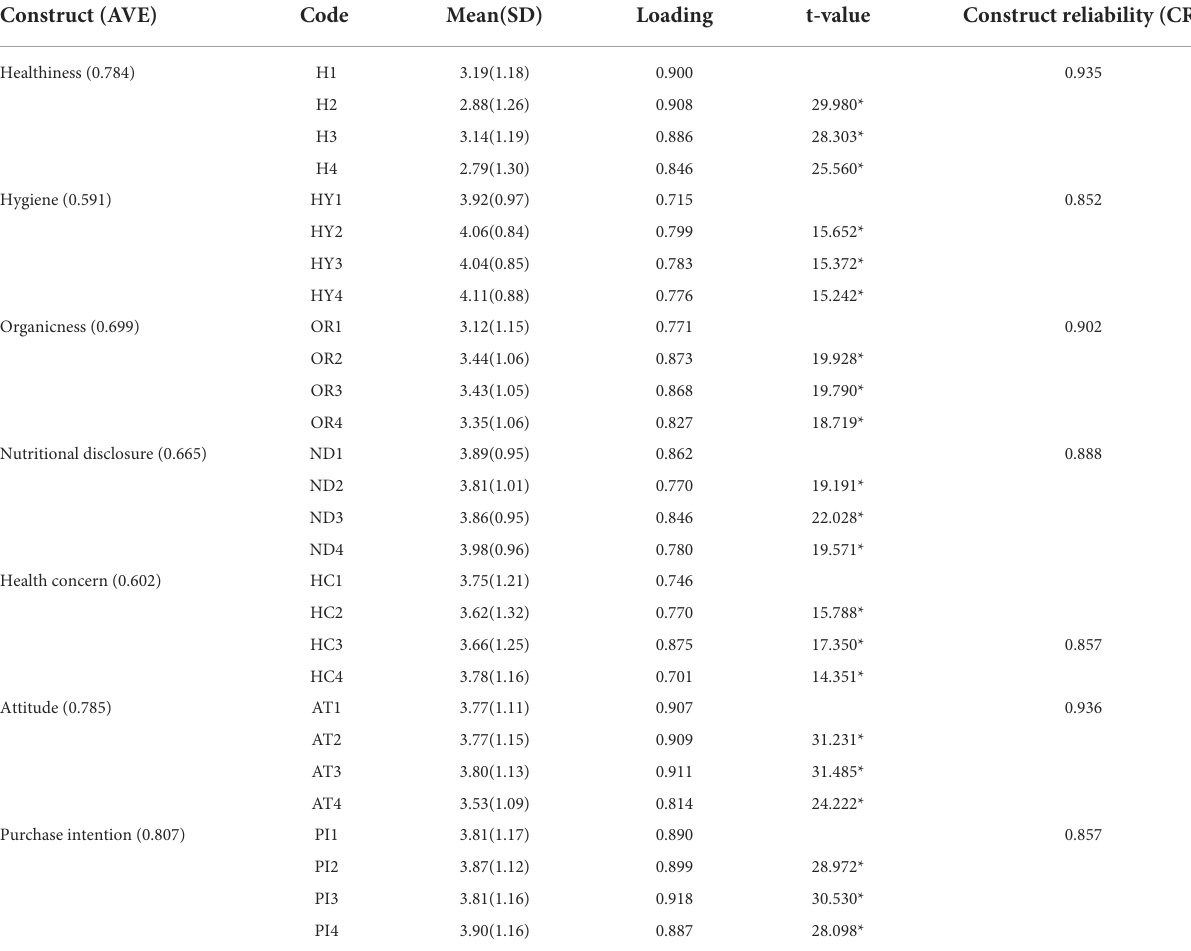
TABLE 3 Mean value and confirmatory factor analysis results.